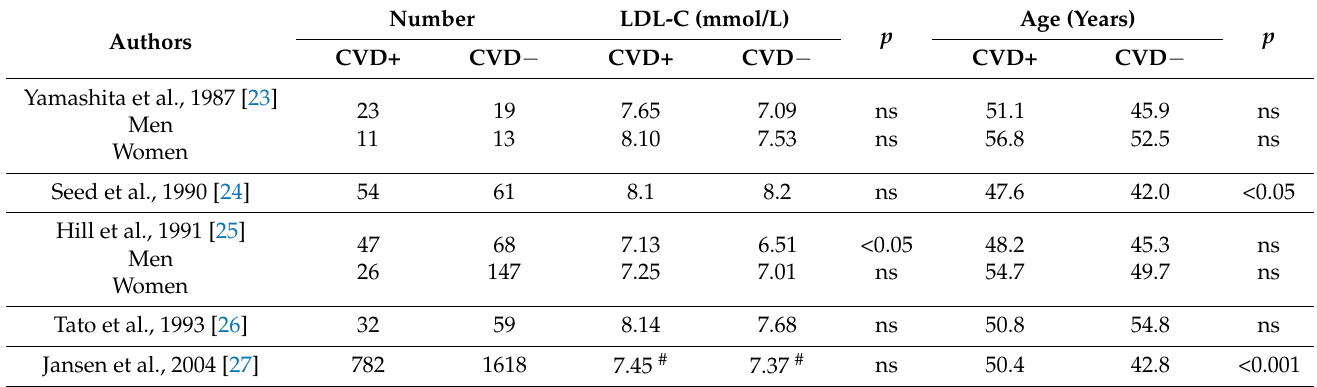
Table 1. Mean LDL-C and mean age in FH individuals with and without CVD in studies published before the introduction of statin treatment [23–26] or including non-treated individuals only [27] None of the participants had been treated with other cholesterol lowering drugs